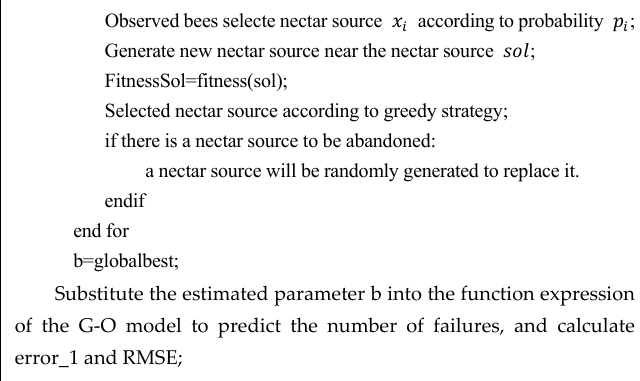
Figure 2. Interpretable code of the algorithm architecture.